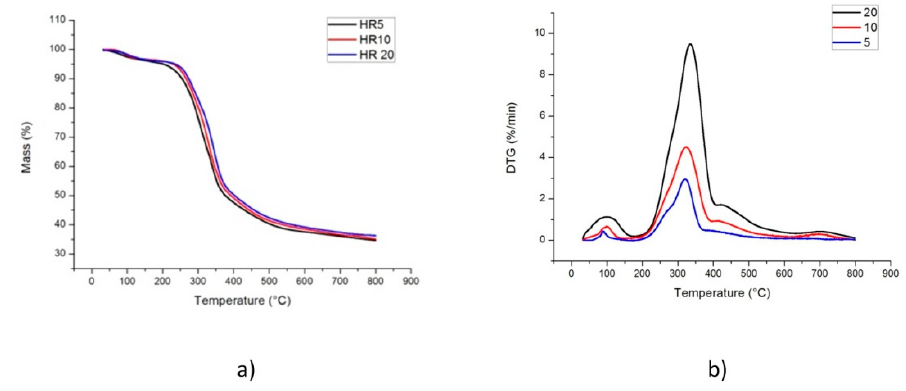
Figure 1. Thermogravimetric ( a ) and Di ff erential thermogravimetric ( b ) curves generated during solid digestate pyrolysis at di ff erent heating rates. Table 1. Thermal degradation characteristics of solid digestate at di ff erent heating rates. Heating Rate ( ◦ C /